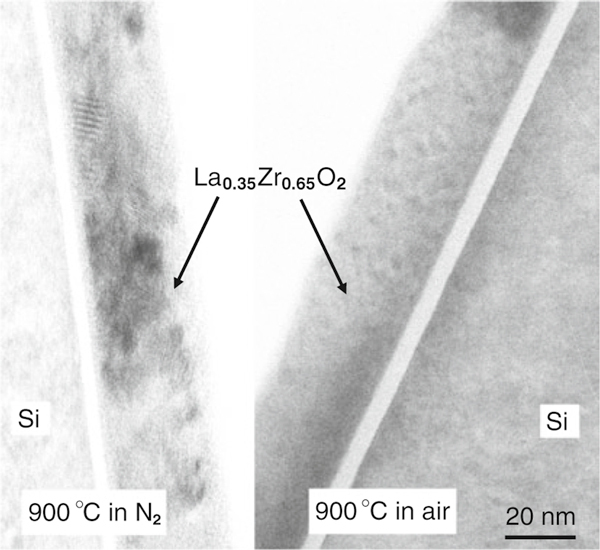
XTEM images from La0.35Zr0.65O2 samples, which were annealed in air and N2 at 900°C for 15 min, respectively.